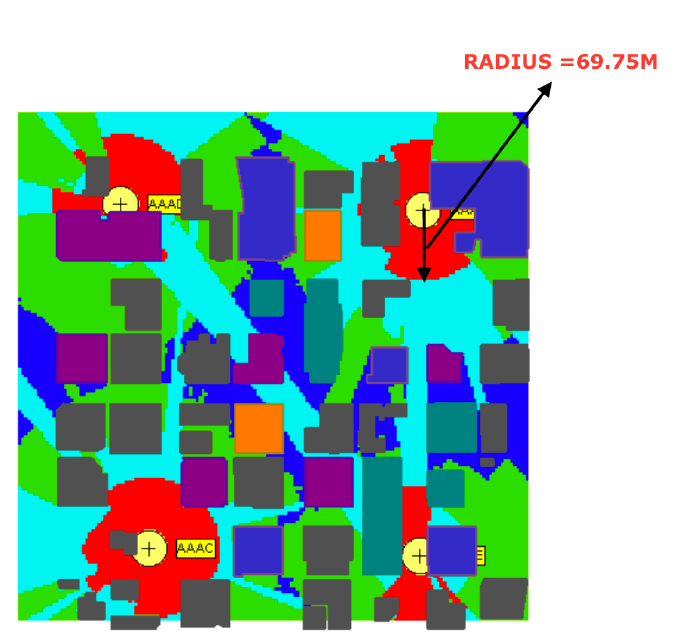
Figure 11. Heuristic site location for outdoor with MISO